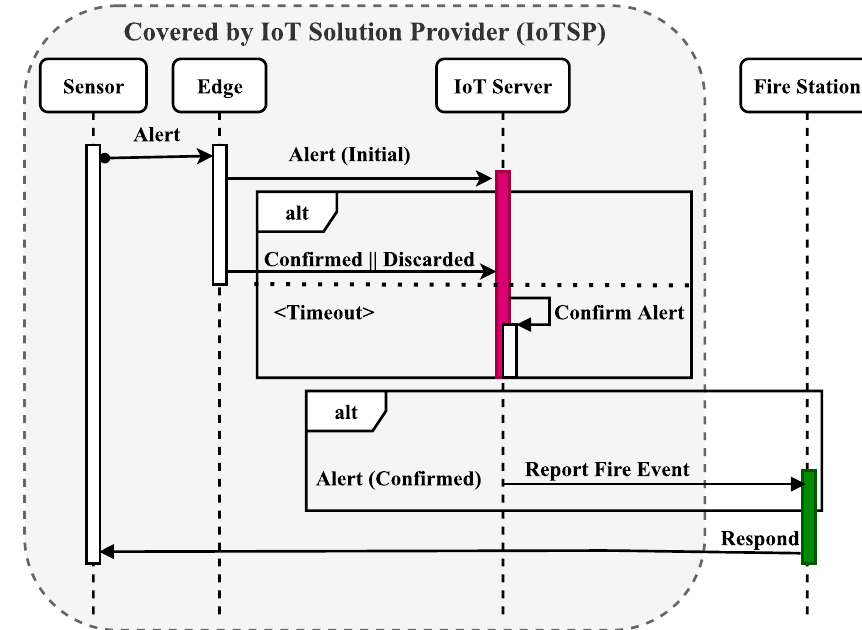
Fig. 3 Stages of a fire event from origination until being